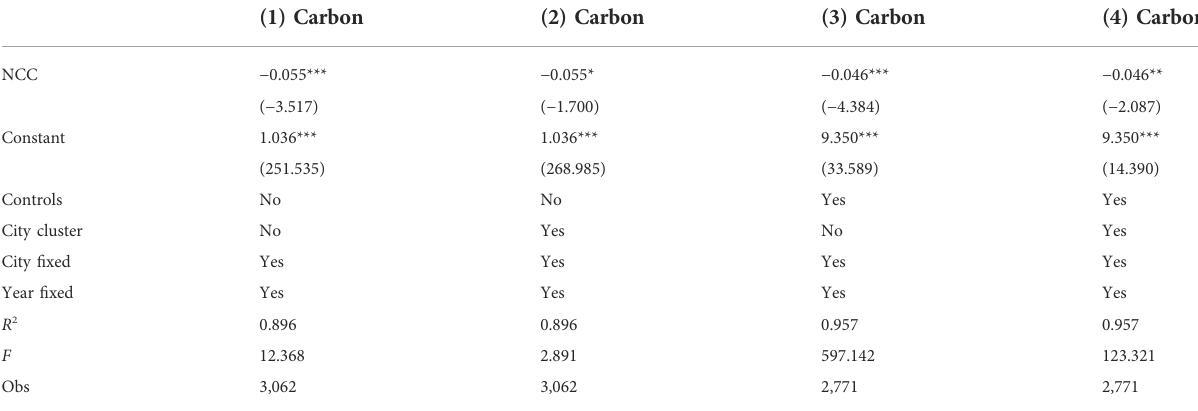
TABLE 4 The results of